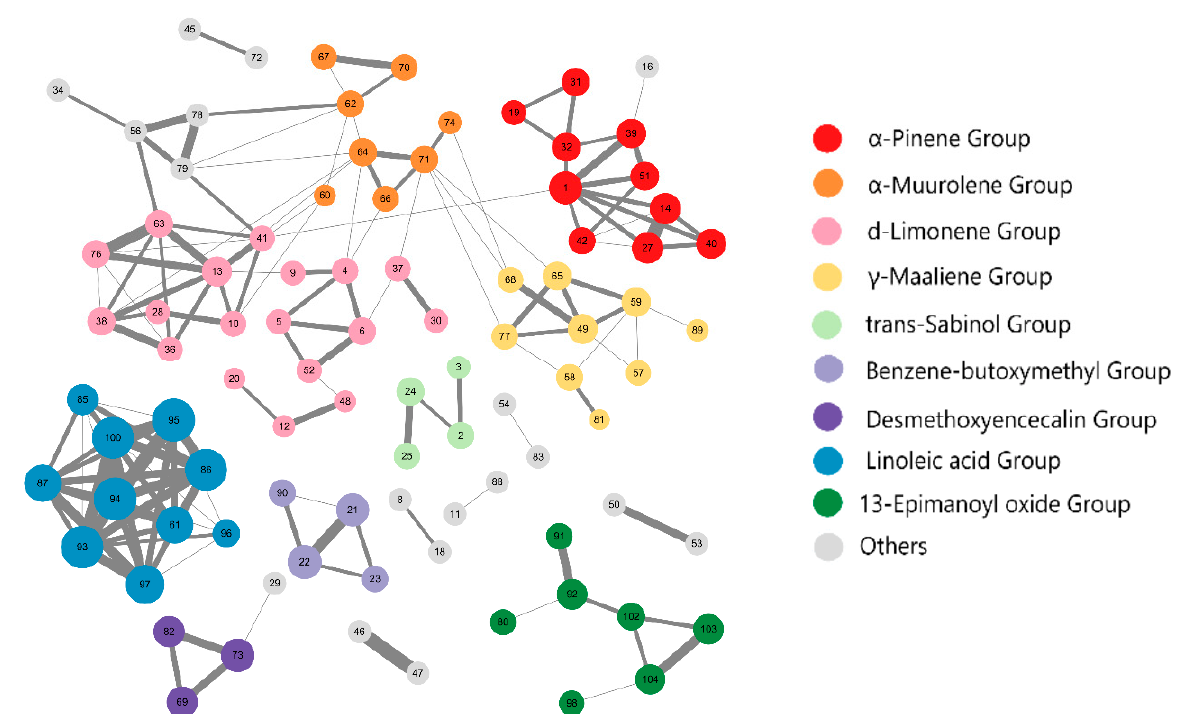
Figure 1. Similarity heatmap for 104 compounds. Where the similarity between molecules is greater, the color is red, and the lower the similarity, the bluer the color. The left part of the figure represents hierarchical clustering calculated according to the similarity values.